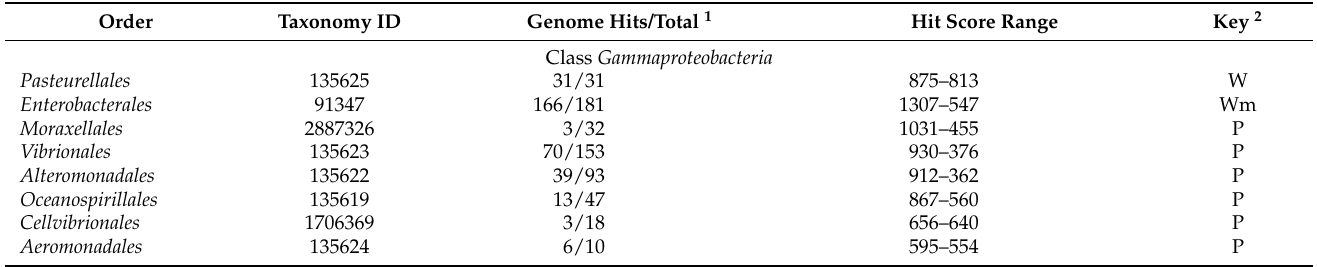
Table 4. Distribution of cpdB -like genes in different orders of classes Gammaproteobacteria and Bacilli , as obtained by TblastN analysis using S. enterica CpdB as the